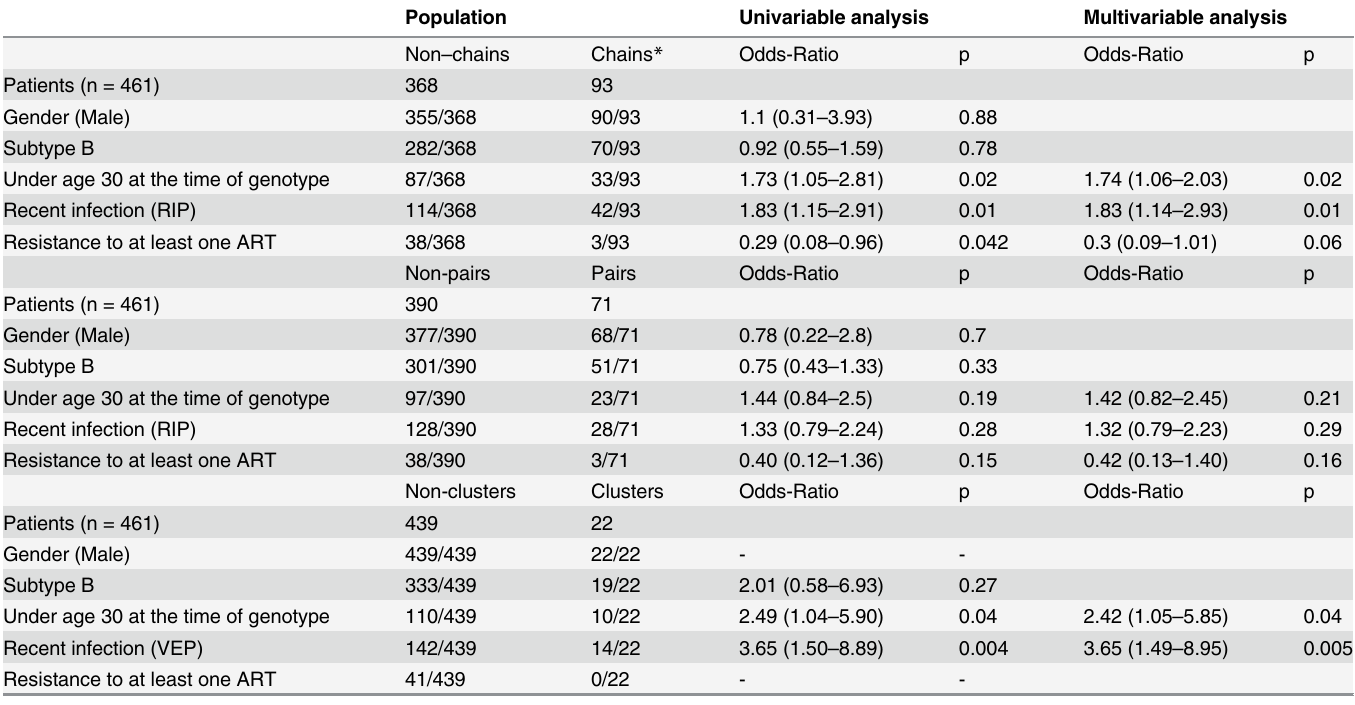
Table 2. Factors associated with inclusion in chains, pairs and